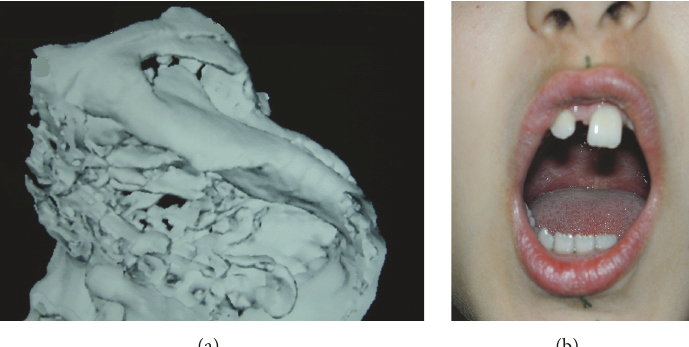
Figure1:(a)AnkylosisoftherightTMJduringthepatient’s(Case 1)firstvisit.(b)Mouthopeningofthepatient(Case